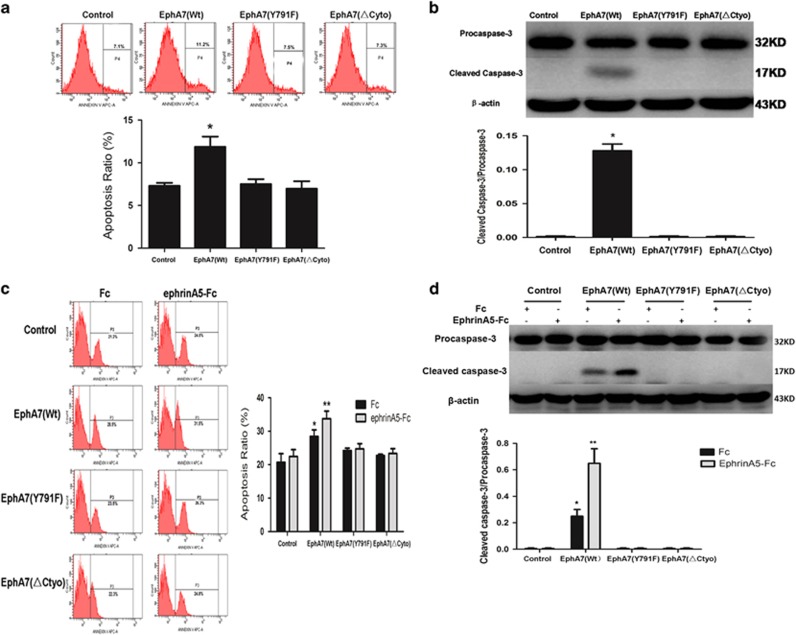
Ligand-dependent promotion of cell apoptosis by EphA7 in PCa. (a) DU145 cell apoptosis was analyzed by FACS after Annexin V-APC staining. (b) Western blot analysis of procaspase-3 and cleaved caspase-3 expression in DU145 cell-overexpressing EphA7(WT) receptor or EphA7 mutants. (c) PC-3 cell apoptosis was analyzed by FACS after Annexin V-APC staining. A total of 5 × 106 PC-3 cells overexpressing EphA7(WT) receptor or EphA7 mutants were serum-deprived for 24 h, and treated with 1.0 μg/ml of ephrinA5 ligand or Fc for 15 min. Then, cells were stained using Annexin V-APC and quantified by FACS. (d) Western blot analysis of procaspase-3 and cleaved caspase-3 expression in PC-3 cells overexpressing EphA7(WT) receptor or EphA7 mutants. PC-3 cells overexpressing EphA7(WT) receptor or EphA7 mutants were serum-deprived for 24 h, treated with 1.0 μg/ml of ephrinA5 ligand or Fc for 15 min and lysed. Then, cell lysate was immunoprecipitated with anti-procaspase-3 antibody and anti-cleaved caspase-3 antibody. Data are shown as the mean±S.D. *P<0.05 versus the control group. **P<0.05 versus the respective EphA7(WT) expression group